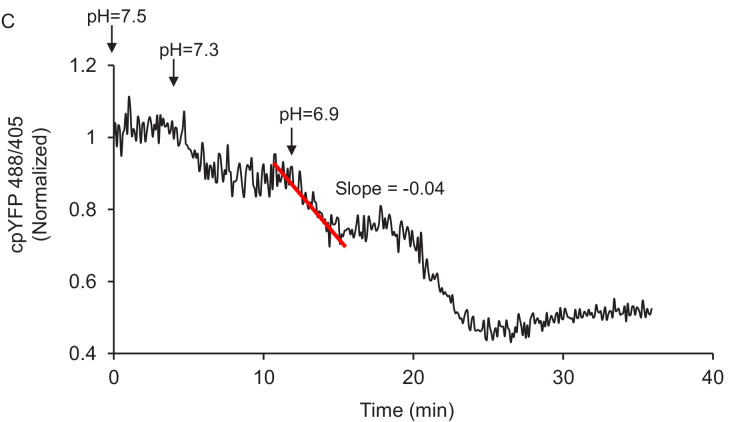
Method of quantitation of the slope of mt-cpYFP fluorescence ratio change after permeabilized cells are exposed to external pH 6.9.The trace is from old rat cardiomyocytes.